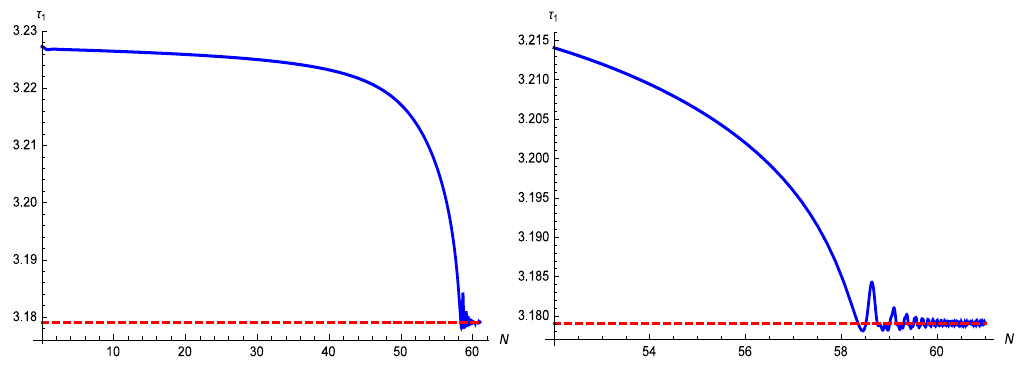
Figure 8 . Evolution of τ 1 as a function of the number of efoldings N for (left) the entire inflationary dynamics and (right) for the last 6 efoldings. The dashed red line represents the position of the final global minimum.